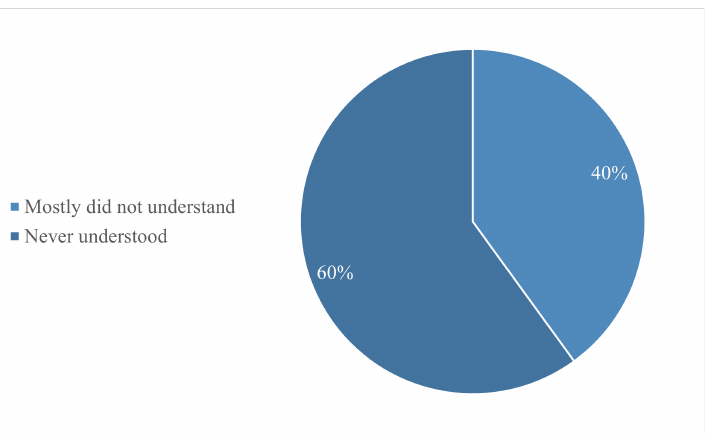
Figure 22. Answers to the question “How well did you understand what component to select?”.